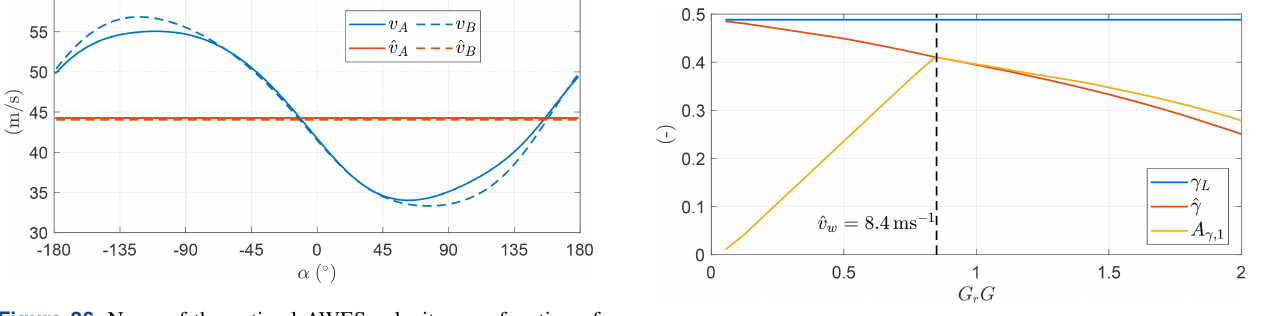
Figure 38. Optimal values of ˆ γ and A γ, 1 as a function of G r G .